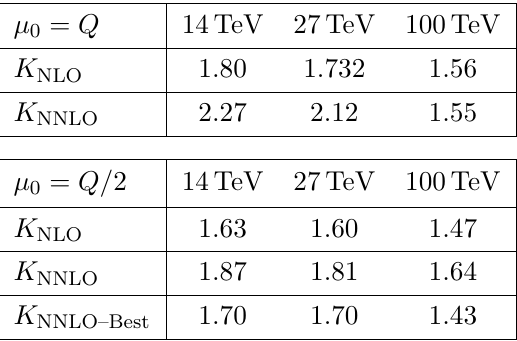
Table 2 . NLO and NNLO K factors for the inclusive triple Higgs boson production at di(cid:11)erent collider energies. These de(cid:12)ned as the quotient between the dBi and the LO cross section. The results are shown for central scale values of Q (top) and Q= 2 (bottom). The dependence on (cid:24) in the dBi (cid:24) reweight procedure is below the per-mill level and therefore omitted. The last row shows our best available prediction for the di(cid:11)erent collider